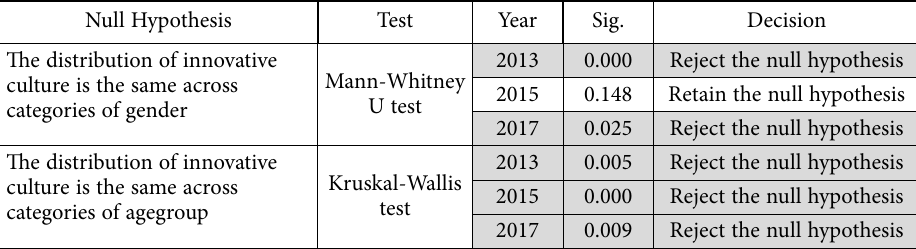
Table 5. Hypotheses verification – innovative culture (source: Prepared by the authors) Null Hypothesis